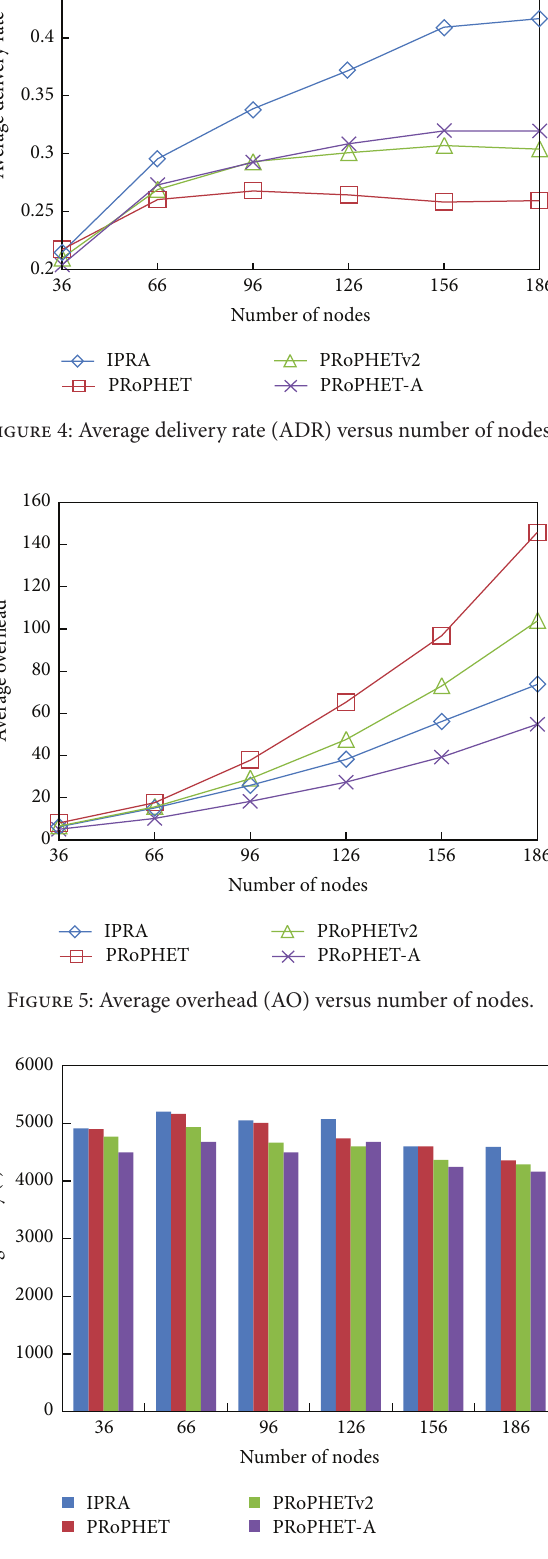
Figure 6: Average delay (AD) versus number of nodes.